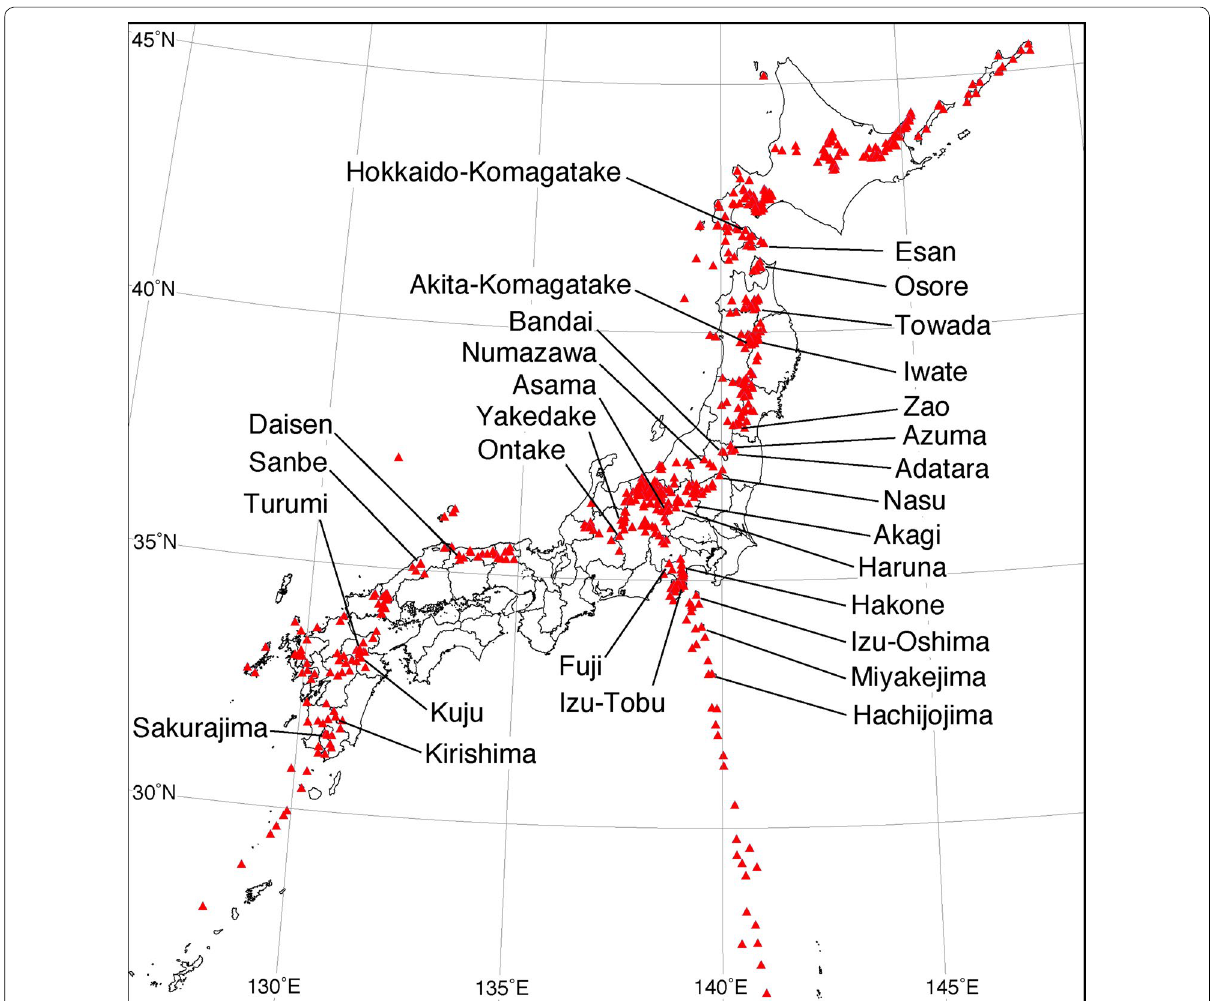
Fig. 1 Index map of 29 volcanoes calculated volumetric eruption rates. Red triangles are Quaternary volcanoes in